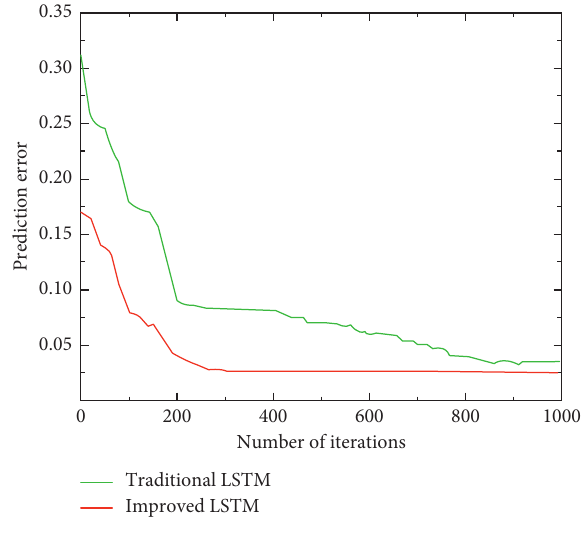
Figure 7: Iterative optimization Table 3: Error comparison.